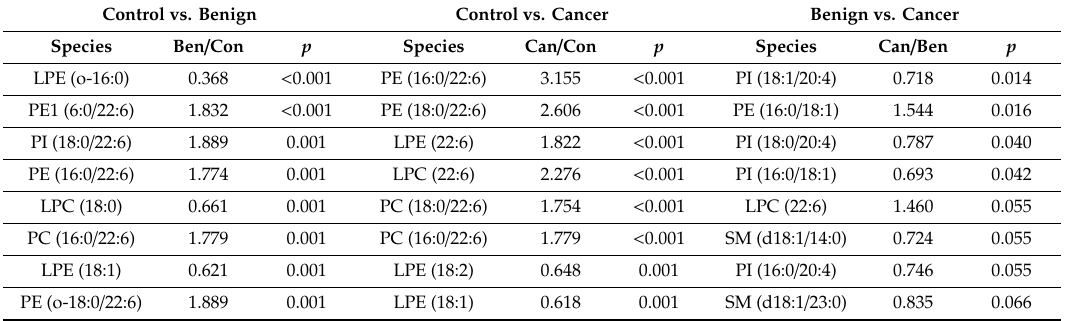
Figure 2. A heat map provides intuitive visualization of a difference in the phospholipid profile between the control, benign tumor, and ovarian cancer patients. Table 1. The content of phospholipids, lysophospholipids, and sphingomyelin by normalizing the intensities of individual peak areas to the areas of internal standards. Control vs. Benign Control vs. Cancer Benign vs.